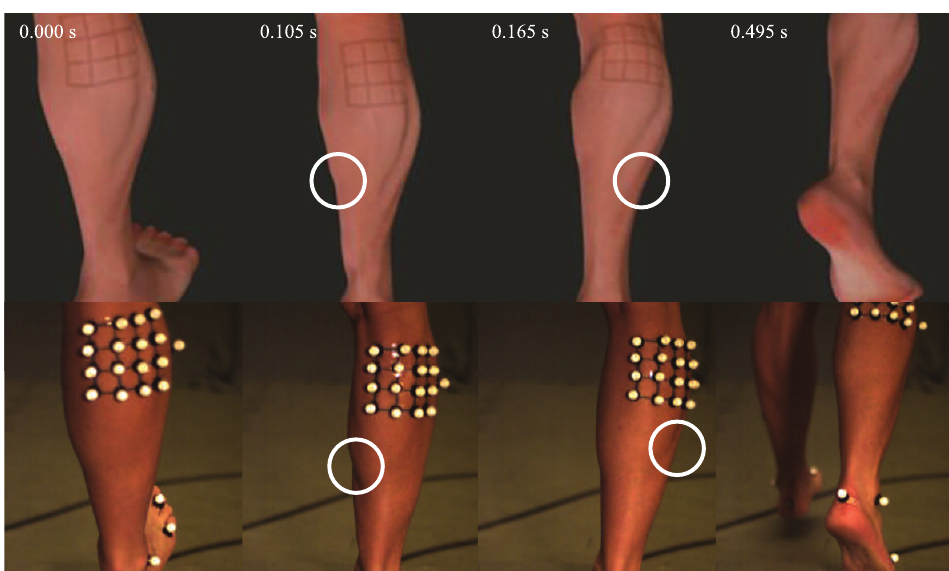
Fig. 6 Skin deformation simulated by our method (top) and corresponding images from high-speed video recording (bottom). Similar skin folds are to be seen, especially in the white circle.